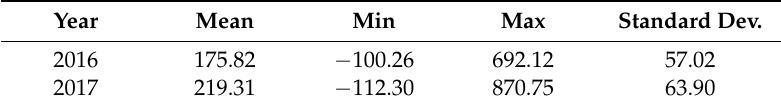
Table 2. 2016–2017 descriptive statistics for electricity prices (DKK/MWh).